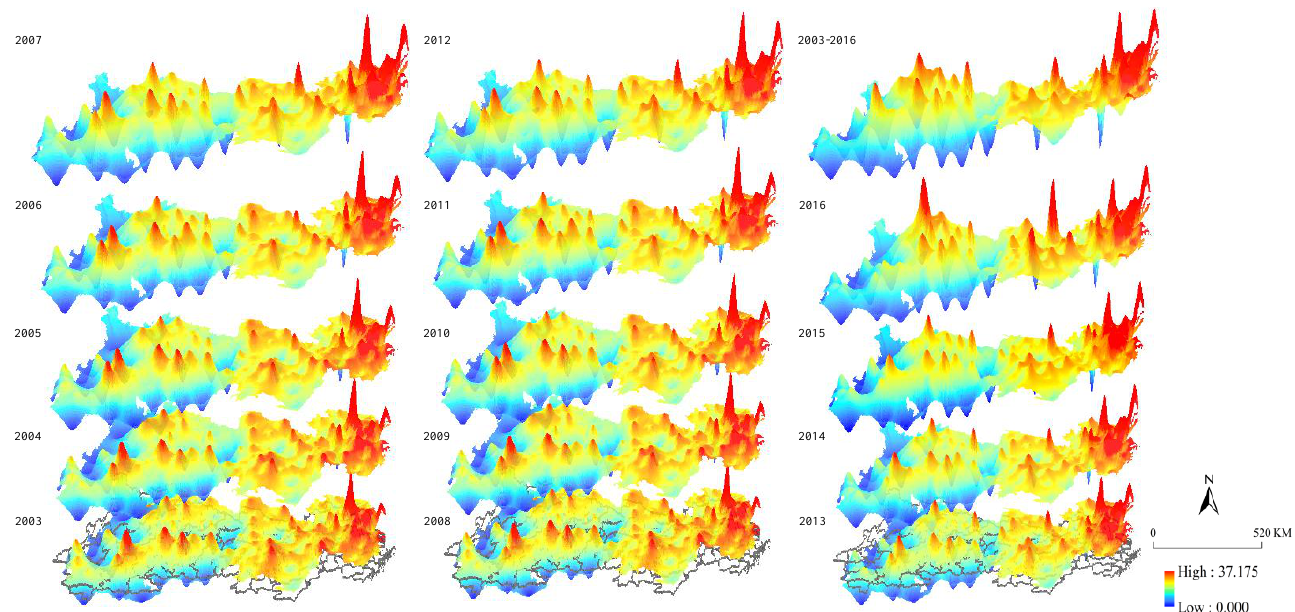
Figure 5. Spatial evolution pattern of the GD in the YREB.